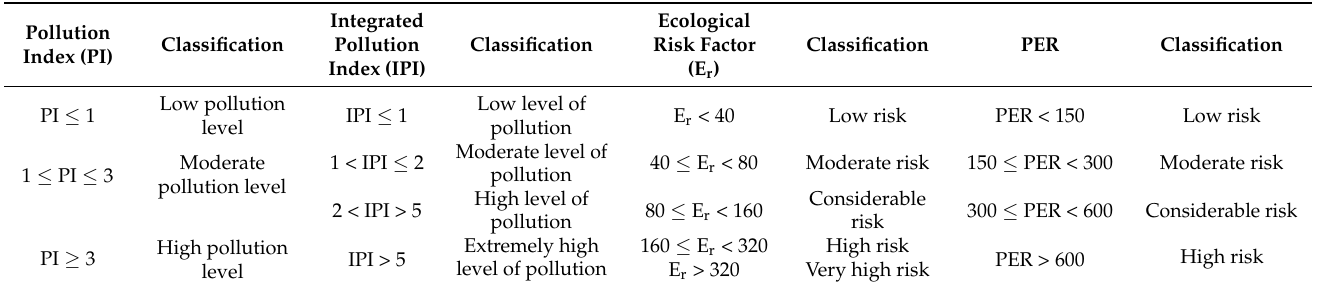
Table 2. Pollution index (PI), integrated pollution index (IPI), ecological risk factor (ER), and potential ecological risk (PER) classification.